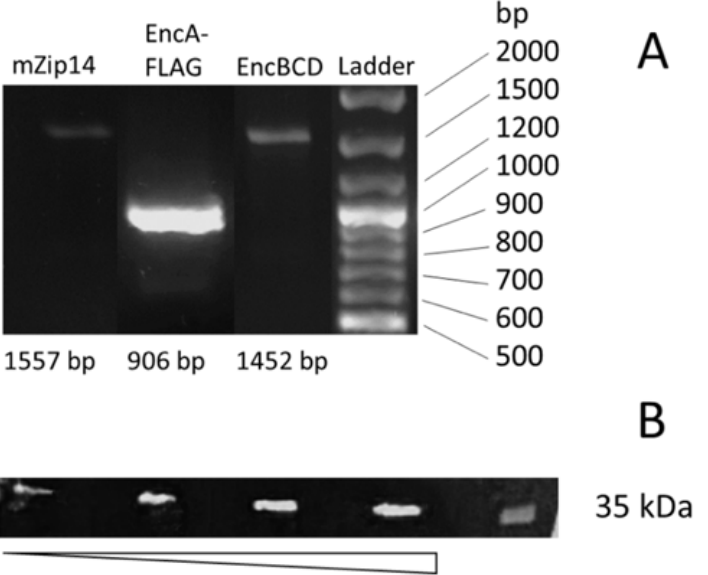
Figure 2. ( А ) Reverse transcription-polymerase chain reaction (RT-PCR) analysis of hAD-MSCs-Mx; ( В ) Western blot analysis against FLAG-tag on protomer proteins.